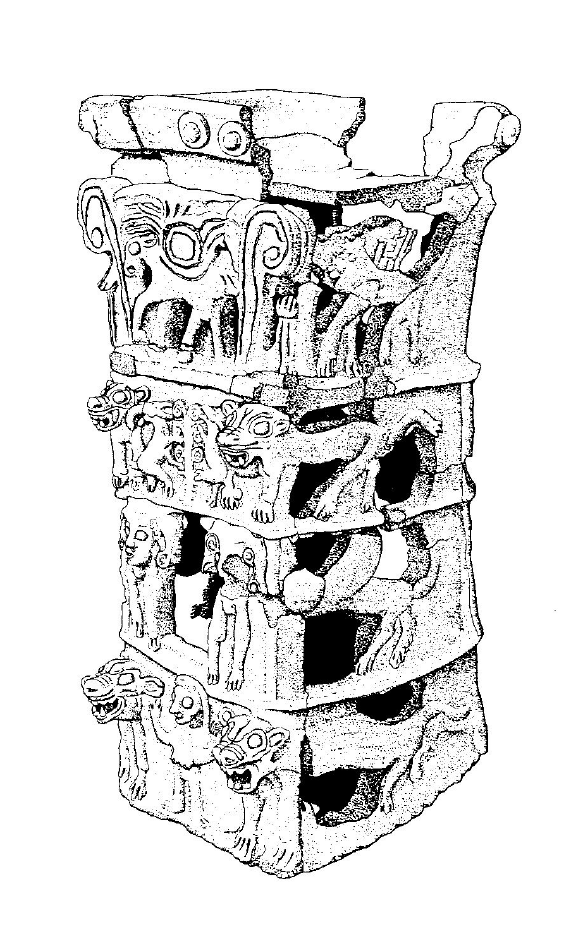
Figure 7 Terracotta cult stand (Taanach, Iron Age